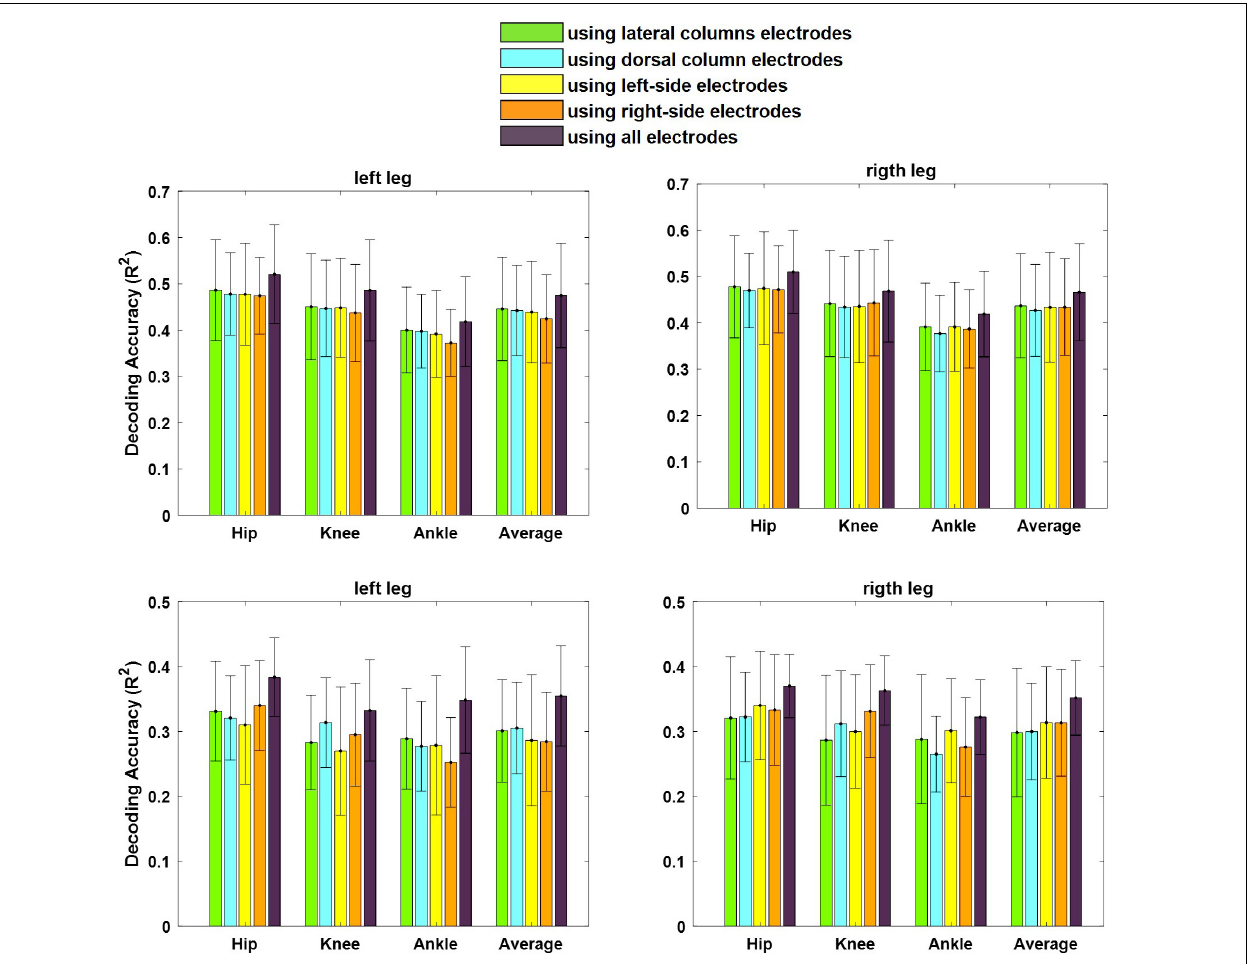
FIGURE 12 | Average of decoding performance for both left and right legs using the LFP signals recorded from electrodes implanted in the lateral columns (electrodes 1, 4, 5, and 8), dorsal columns (electrodes 2, 3, 6, and 7), left-side of the spinal cord (electrodes 3, 4, 7, and 8), right-side of the spinal cord (electrodes 1, 2, 5, and 6), and all eight electrodes. The error bar on each bar graph represents the standard deviation. The results are obtained from cat 1 (top) and cat 2